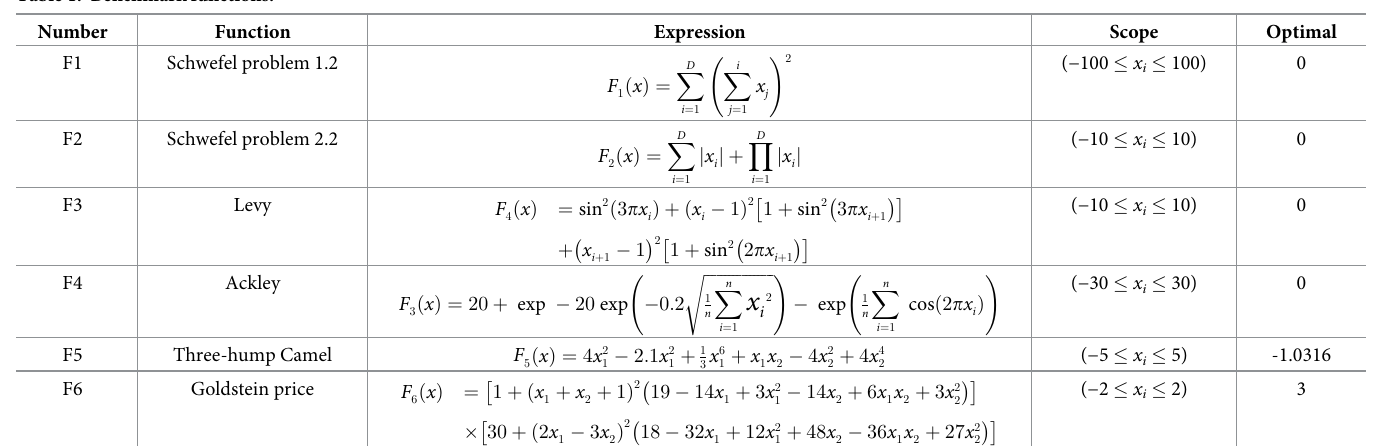
Table 1. Benchmark functions.